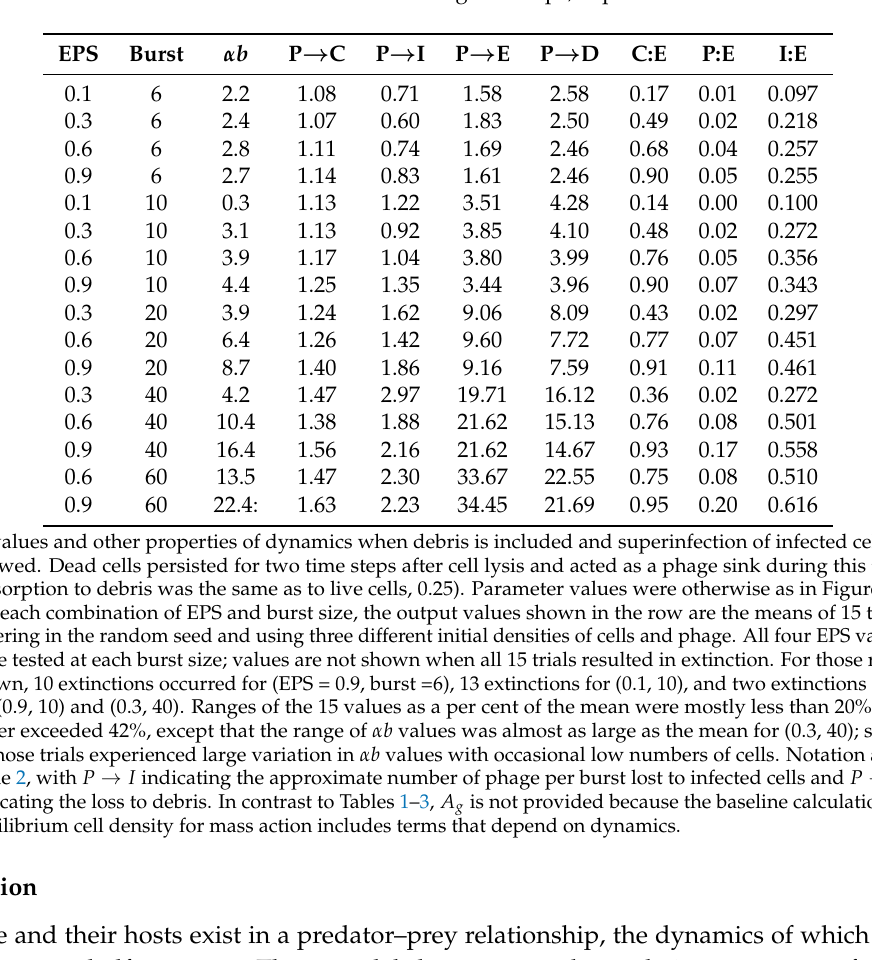
Table 6. Random EPS with debris lasting two steps, superinfection